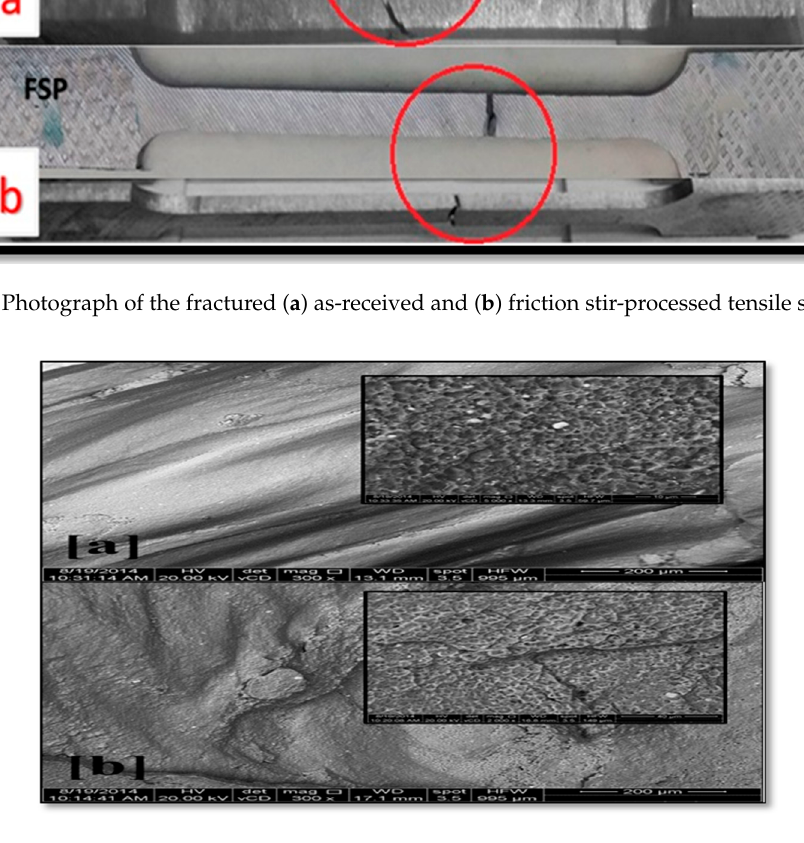
Figure 10. SEM micrograph of fracture zone in AMMNCS specimen friction stir-processed at 1120 rpm at 15 mm/min; ( a ) first pass and ( b ) third pass.